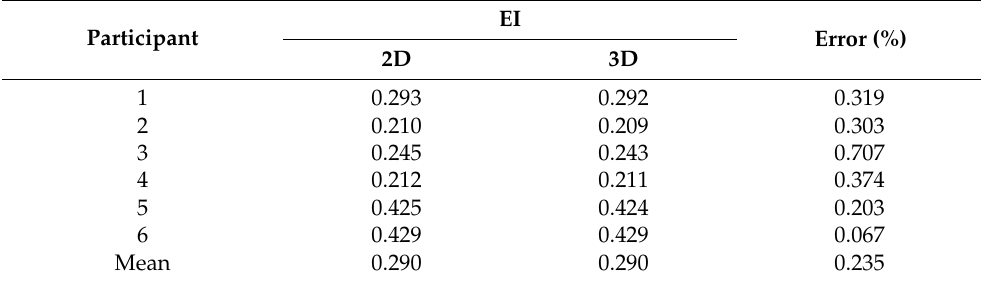
Table 8. Differences and relative error between EI 2D and EI 3D .